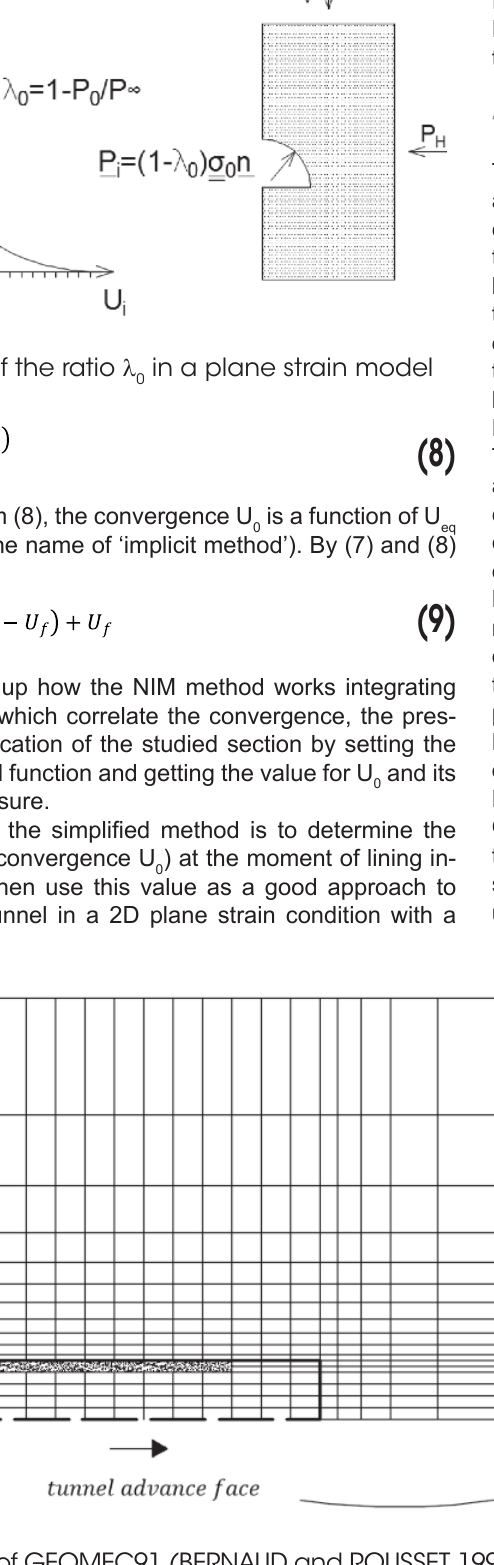
Application of the ratio λ